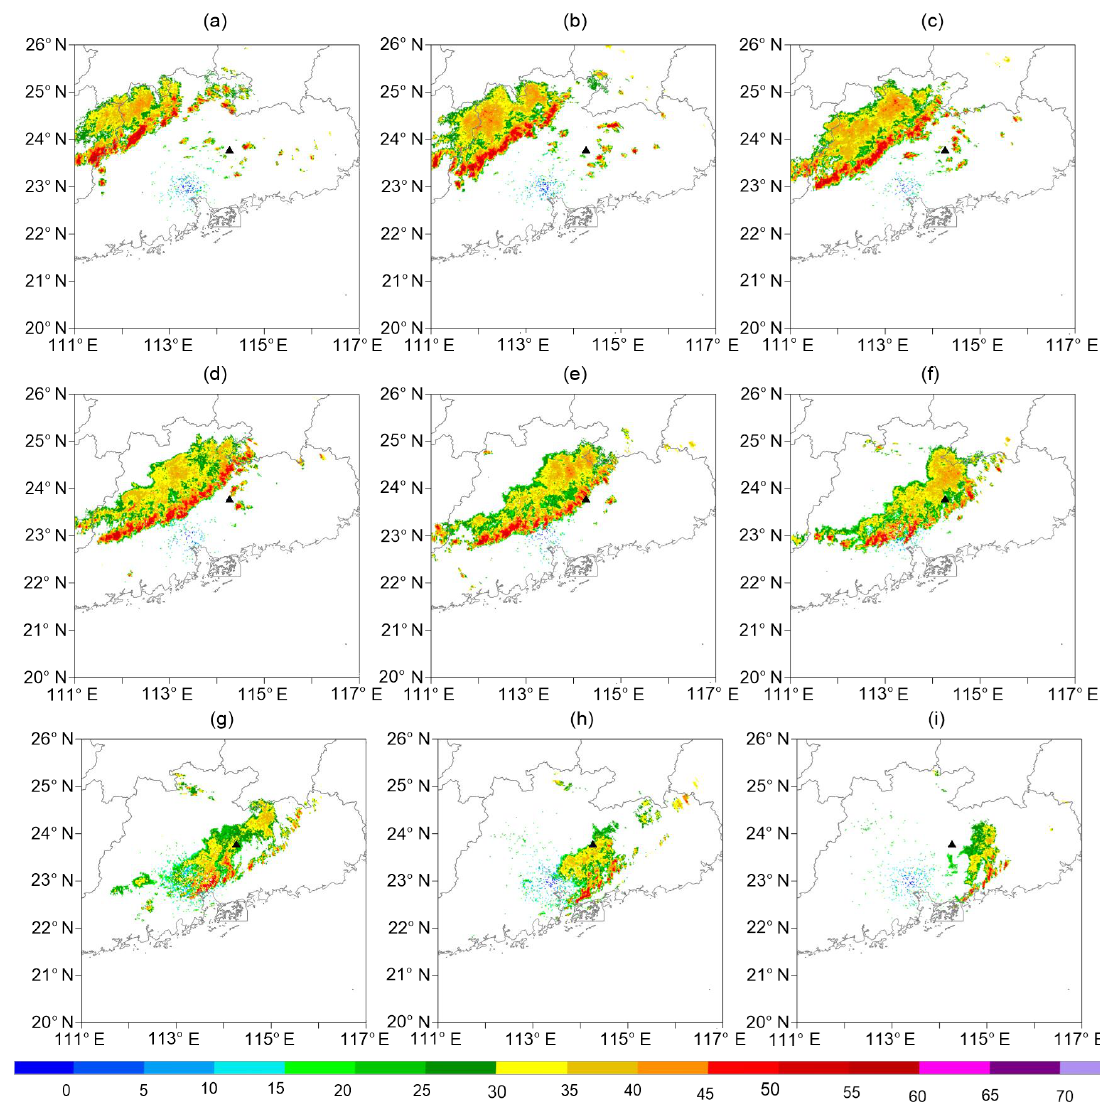
Figure 1. Radar echo of the squall line determined by the dual-polarization S-band weather radar of Guangzhou from 0600 to 1400 UTC on May 6, 2016: ( a ) 0600, ( b ) 0700, ( c ) 0800, ( d ) 0900, ( e ) 1000, ( f ) 1100, ( g ) 1200, ( h ) 1300, and ( i ) 1400 (the black triangle marks the position of the Ka-band cloud radar).